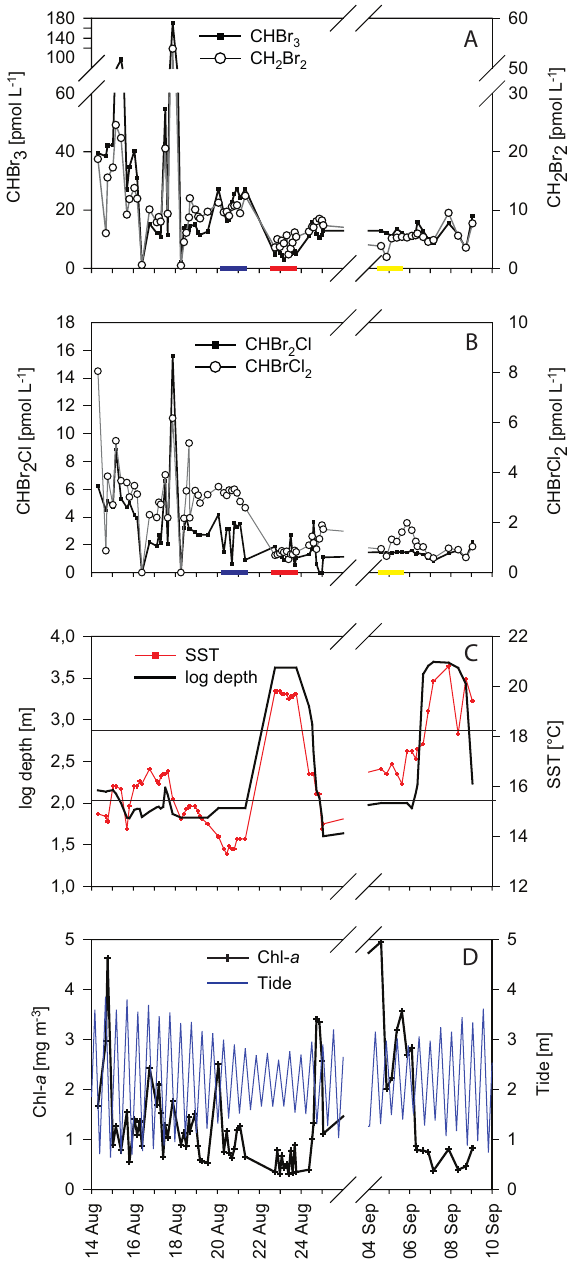
Fig. 4. Times series of bromocarbons and ancillary variables (mean values in the upper layers). (A) , (B) CH 2 Br 2 , CHBr 3 , CHBr 2 Cl and CHCl 2 Br. Sampling at fixed stations are marked with the colour code for the different water masses: Blue: recently upwelled waters. Yellow: aged upwelled waters. Red: Open Ocean waters. (C) Bot- tom depth and SST. Horizontal lines are borders for the SST-cluster. (D) Chl- a concentration and tidal